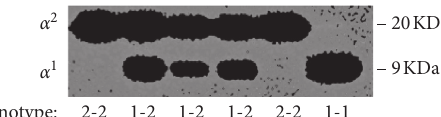
Figure 1: Hp-phenotypization by Western immunoblot in plasma samples of obese pediatric subjects. Diluted plasma samples from six representative obese pediatric subjects were analyzed by WIB under reduced condition to identify the Hp phenotype using a specific antibody against the α -chain. The band ∼ 9kDa corresponds to the α 1 -chain, whereas the band at ∼ 20kDa corresponds to the α 2 -chain. In the presence of only one band, 20kDa or 9 kDa, the phenotype was, respectively, 2-2 and 1-1; when both bands were detectable, the phenotype was heterozygous